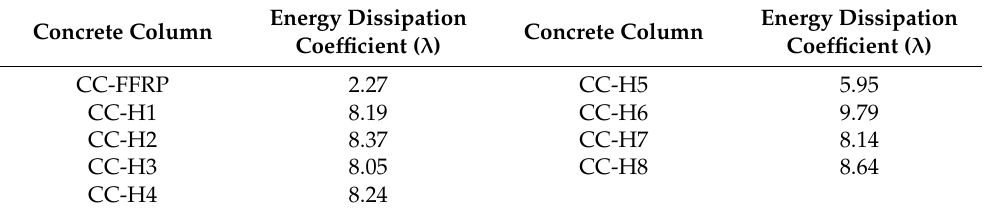
Table 6. Energy dissipation coefficients of concrete cylindrical specimens under different